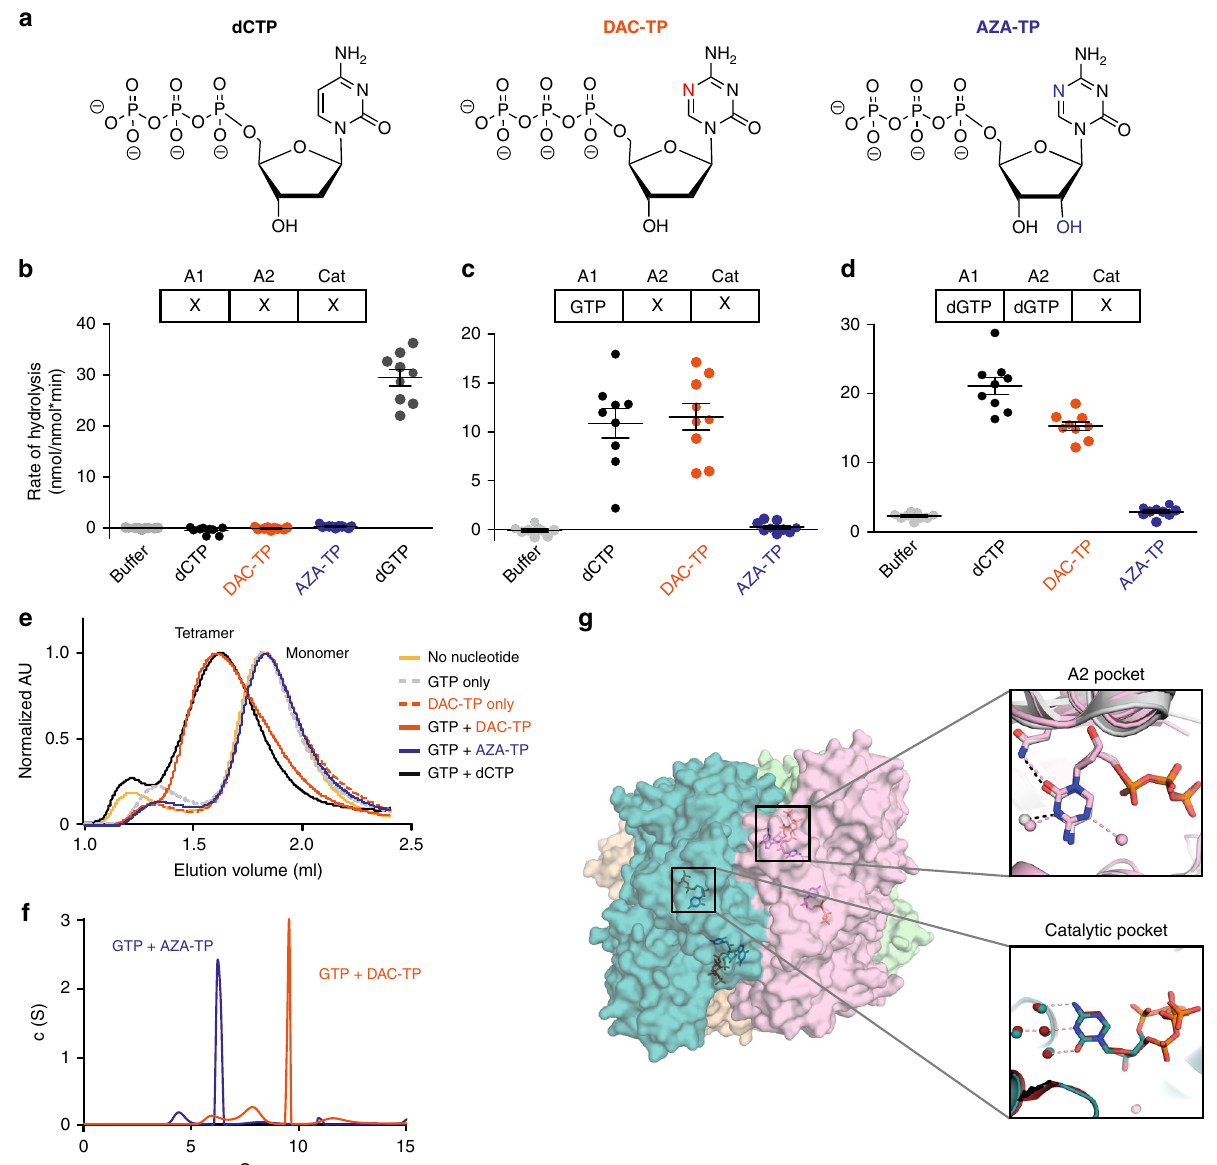
Fig. 1 DAC-TP, but not AZA-TP, is an allosteric activator and substrate of SAMHD1. a Chemical structures of dCTP, decitabine triphosphate (DAC-TP), and azacytidine triphosphate (AZA-TP). b – d dNTPase activity assay for recombinant SAMHD1. The rate of hydrolysis for the indicated nucleotide triphosphates was quanti fi ed in the presence of ( b ) buffer alone, ( c ) GTP, which can occupy allosteric site 1 (A1), or ( d ) dGTP, which can occupy A1 and allosteric site 2 (A2). Cat: Catalytic site. e Size-exclusion chromatograms of SAMHD1 in absence of nucleotide (yellow line) or in the presence of GTP alone (gray dashed line), DAC-TP alone (orange dashed line), GTP + DAC-TP (orange line), GTP + AZA-TP (blue line), or GTP + dCTP (black line). f Sedimentation velocity of SAMHD1 incubated in the presence of GTP in combination with either AZA-TP or DAC-TP. g Structure of the SAMHD1 tetramer in complex with DAC-TP. Each SAMHD1 subunit is shown as a surface representation, colored in light pink, deep teal, light green and wheat. In the insets, nucleotides are shown as sticks. (Top, right panel) An overlay of SAMHD1 structures in complex with dCTP (PDB ID: 4TNP; gray) or DAC-TP (light pink) in allosteric site 2. (Bottom, right panel) An overlay of SAMHD1 structures in complex with dCTP (PDB ID: 4TNP; gray) or DAC-TP (deep